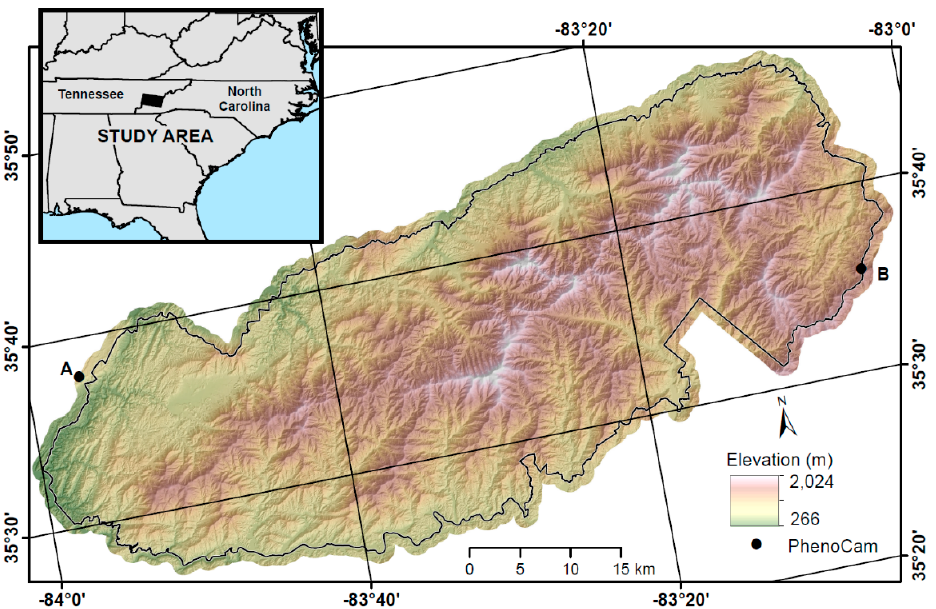
Figure 1. Location of the Great Smoky Mountains National Park study area with respect to the Southeastern USA. Dots show the location of the Smokylook (A) and Smokypurchase (B) PhenoCams used in this study.